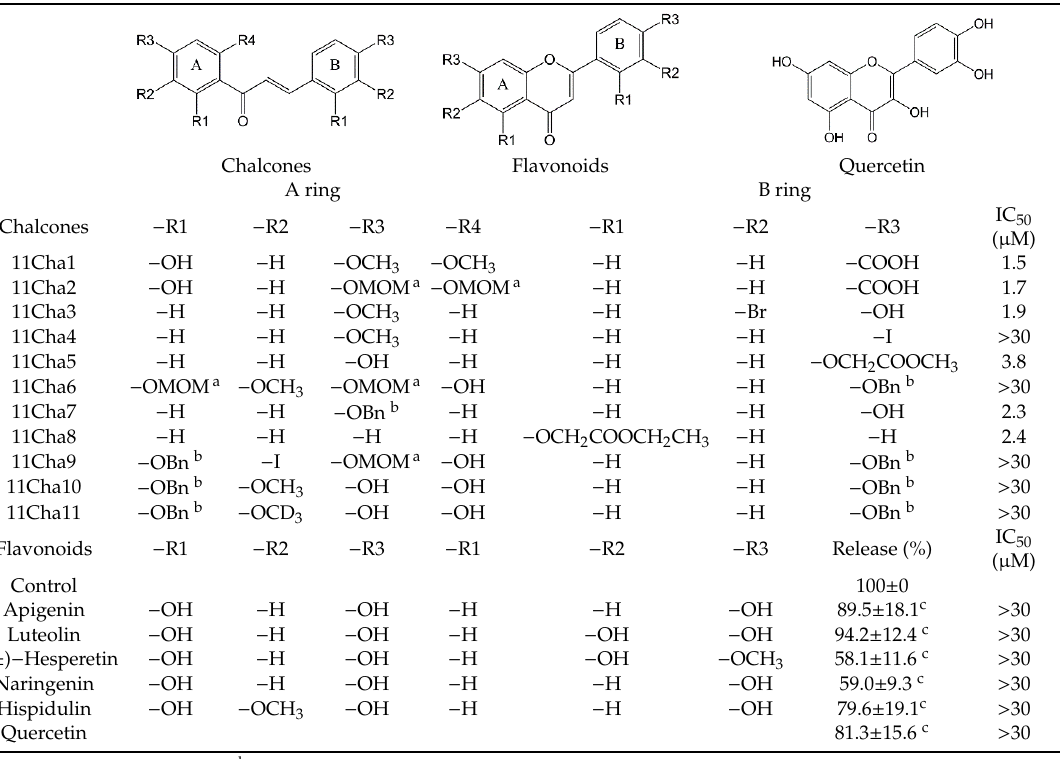
Table 1. IC 50 values of the inhibition by chalcone and flavonoid derivatives against LPS-primed ATP-induced pro-caspase-1 processing in differentiated THP-1 cells.